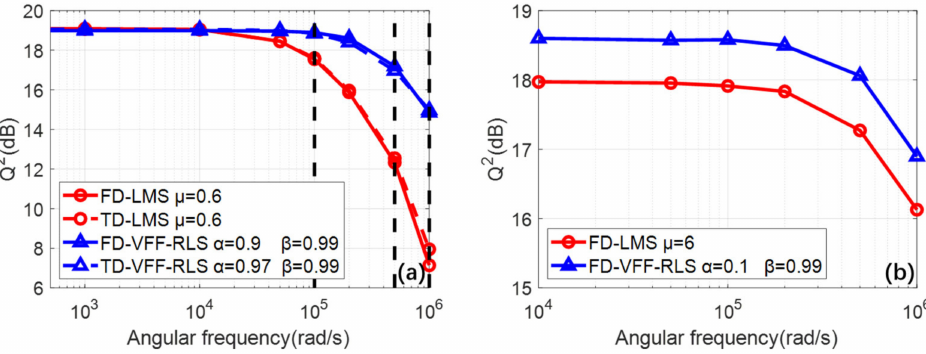
Figure 7. Mean Q 2 factor vs. rotational angular frequency for different algorithm: ( a ) A lower steady-state misalignment with a poorer tracking capability; ( b ) A higher steady-state misalignment with a better tracking